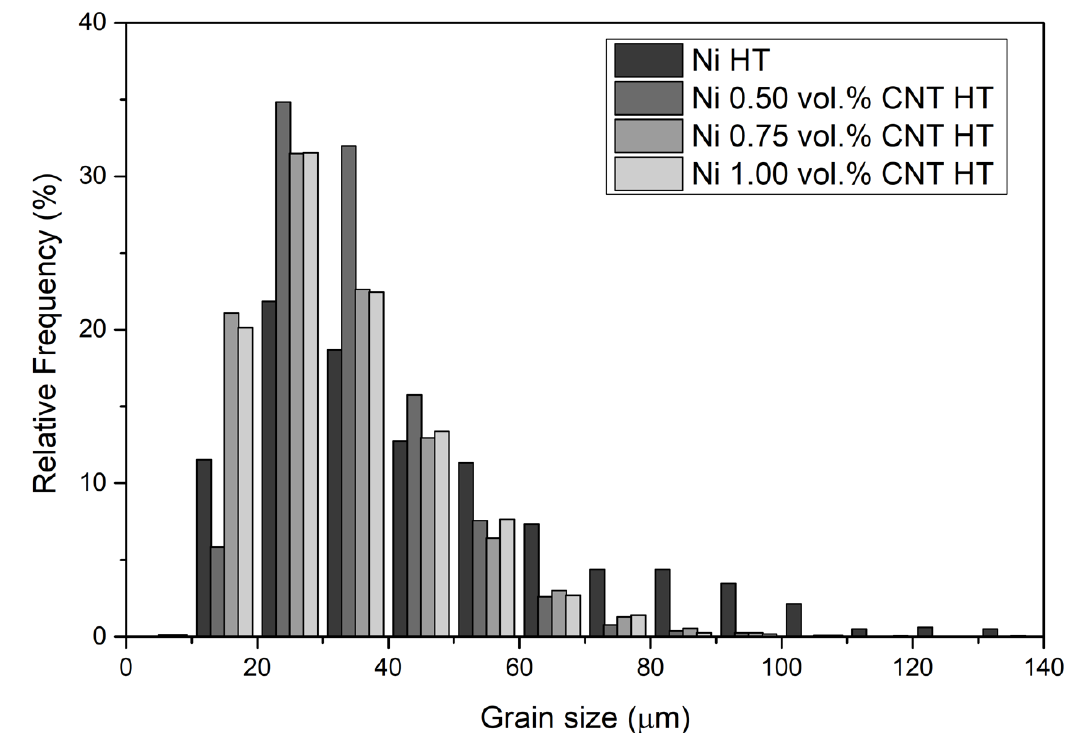
Figure 4. Grain size distributions of Ni and nanocomposites produced with 0.50, 0.75, and 1.00 vol.% of CNT heat-treated (HT) at 1100 °C for 30 min.